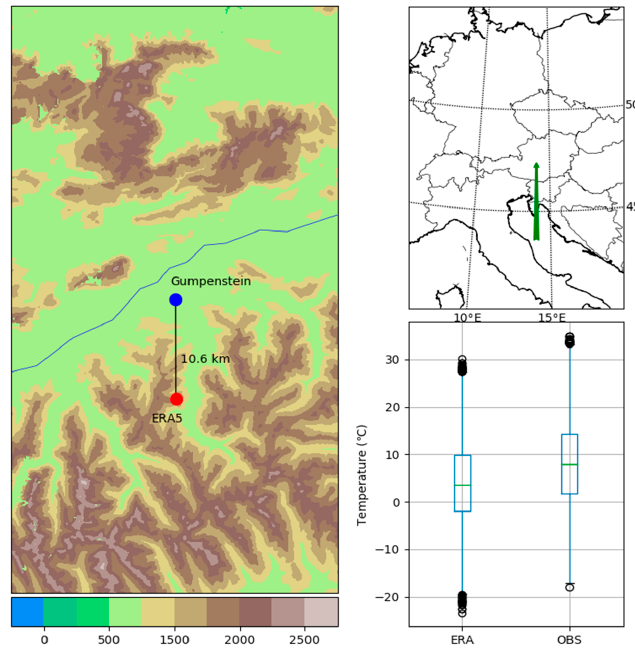
Figure 2. Altitude (m a.s.l.) and position of the Gumpenstein (Austria) automated weather station (AWS).